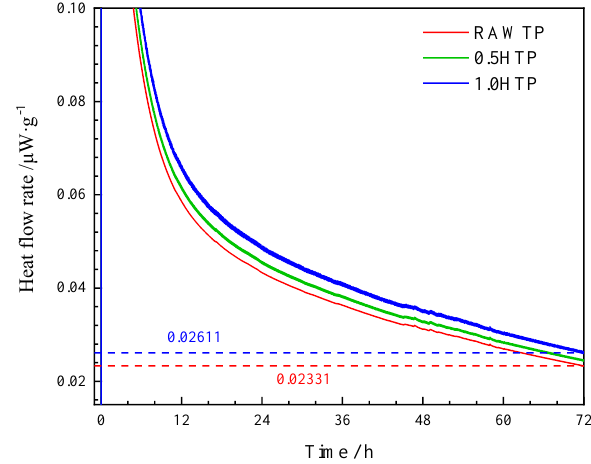
Figure 7. Calorimetry test results of the TPs’ pozzolanic reactivity.